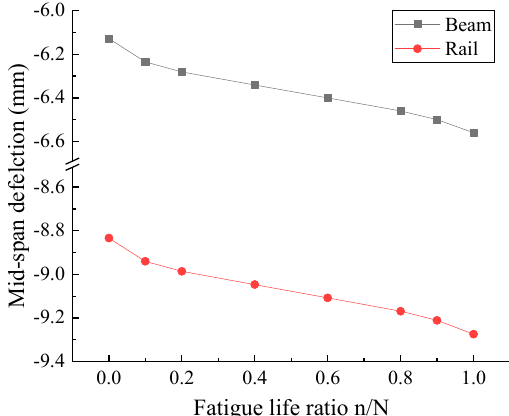
Figure 17. Mid-span deflection curve of beam and rail under fatigue load regardless of CA mortar layer damage. Table 8. Summary of beam and rail deflection variation.